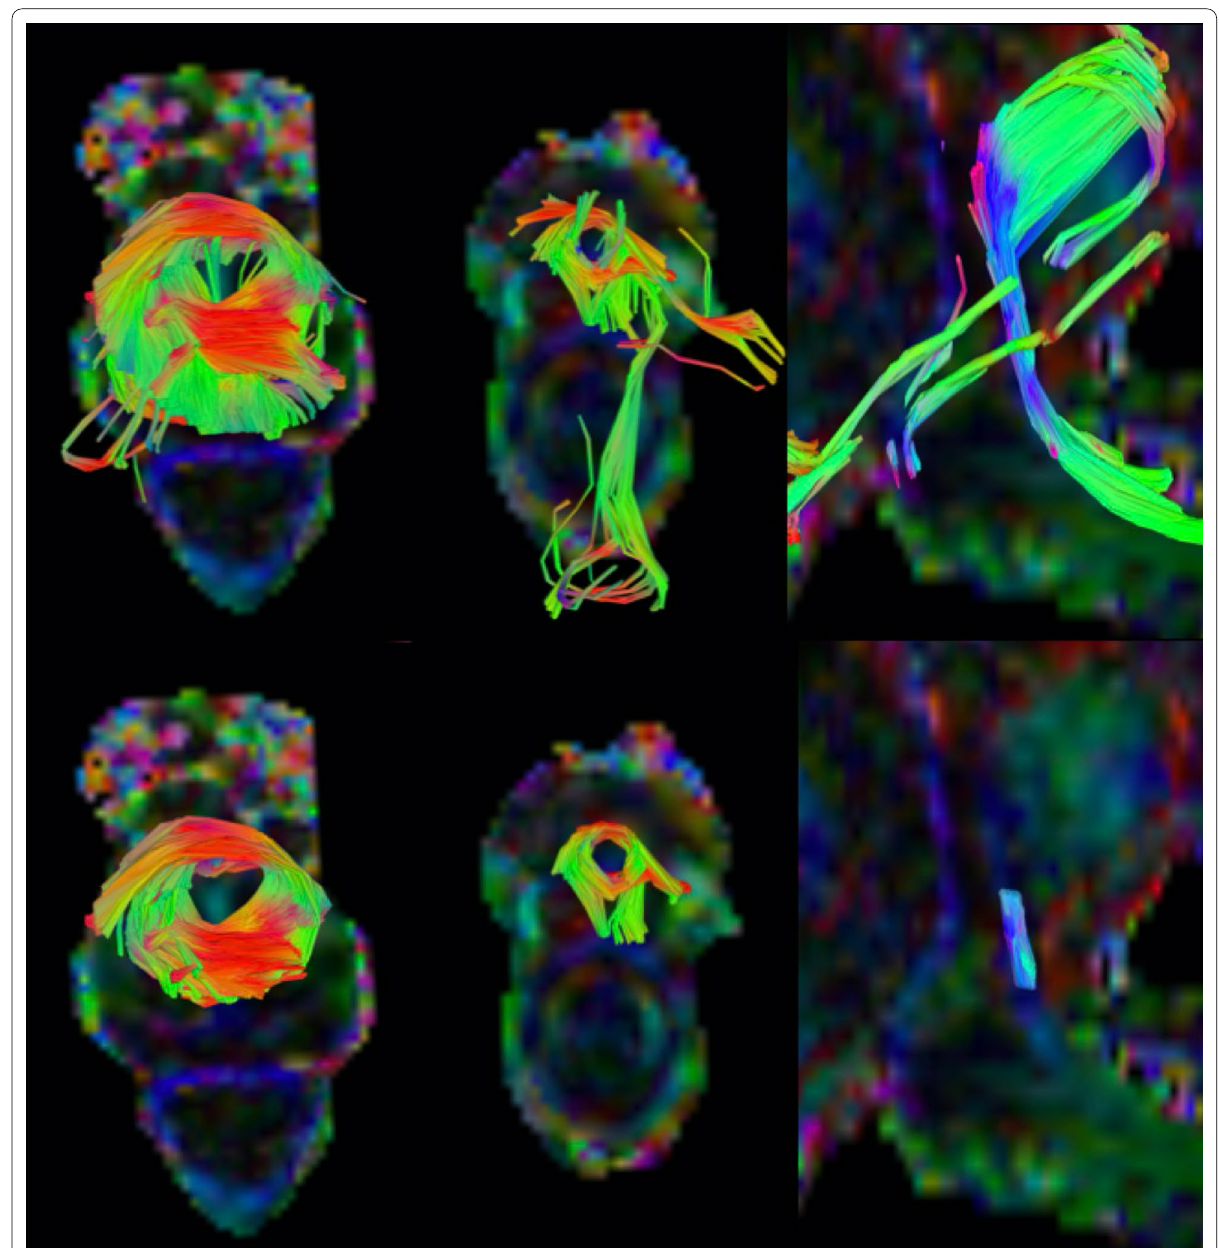
Fig. 5 A representative proximal and distal sphincters and membranous urethra before and after the deletion of spurious fibers on DSI Studio, respectively, from top to